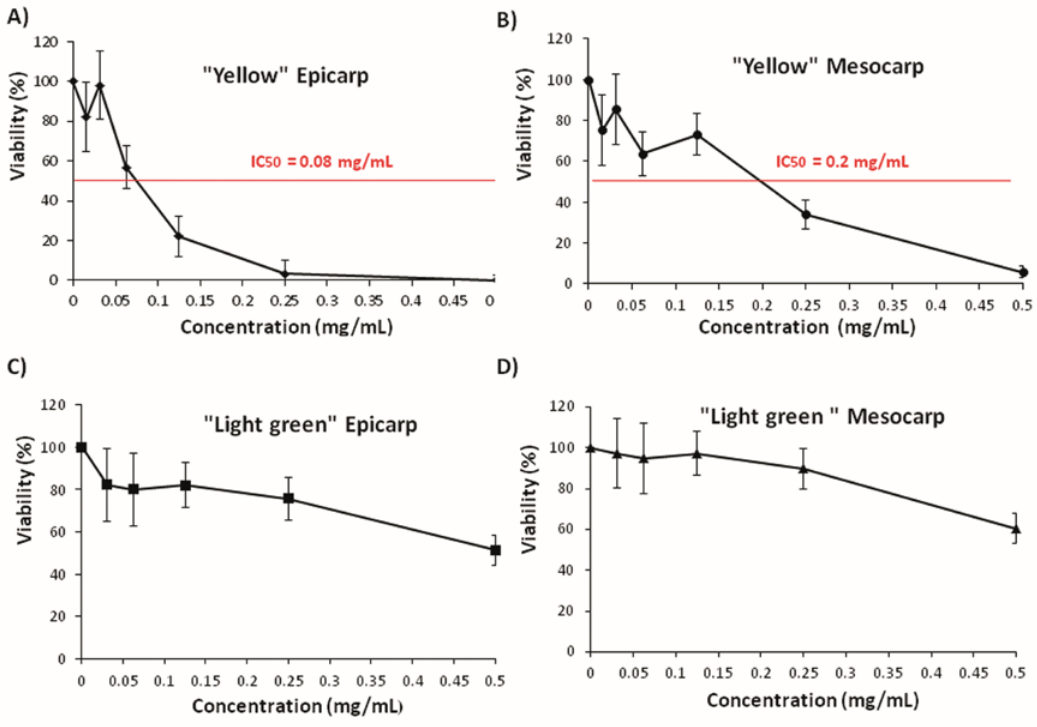
Figure 3. Effects of “yellow” and “Light green” zucchini epicarp (( A ) and ( C ) respectively) and mesocarp (( B ) and ( D ) respectively) on viability of HL60 (human promyelocytic leukemia cells) tumoral cells. Cell viability was assessed after 72 h by trypan blue exclusion test assay. The data are expressed as percentage with respect to control (mean ± SD from three independent experiments). The IC 50 values (Inhibitory concentration 50) are showed in red. SD: standard deviation.